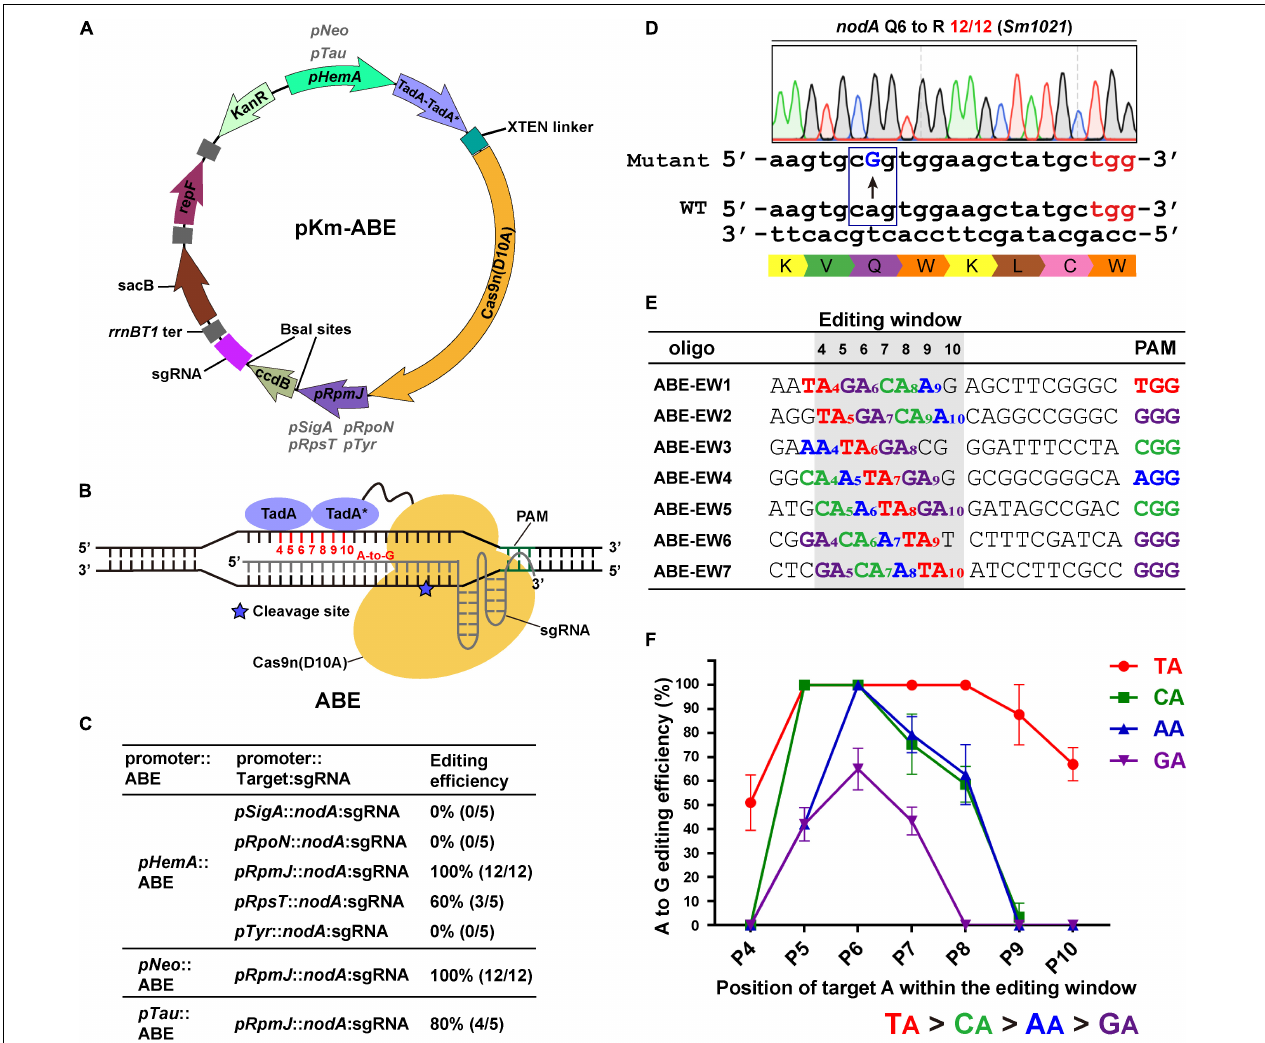
FIGURE 1 | Adenine base editor (ABE) systems catalyze efficient A-to-G conversions in Sinorhizobium meliloti . (A) Map of the pKm-ABE plasmid. KanR: the kanamycin-resistant marker for selection in E. coli and the neomycin-resistant marker for selection in S. meliloti ; repF: pBBR1 origin of replication and oriT from E. coli ; rrnBT1 ter: rrnBT1 transcriptional terminator; sacB : the counter-selectable marker for plasmid curing after editing; pHemA : the δ -aminolevulinic acid synthetase gene promoter of S. meliloti ; pNeo : the constitutive neomycin cassette promoter; pTau : the taurine-inducible promoter of S. meliloti ; TadA-TadA*-XTEN linker-Cas9n: the Cas9-adenine deaminase fusion protein; pSigA : the housekeeping sigma factor σ 70 gene promoter; pRpoN : the sigma factor σ 54 gene promoter; pRpsT and pRpmJ : the ribosomal protein-related gene promoters; pTyr : the Tyr-tRNA (GTA) gene promoter; ccdB : a Bsa I-flanking ccdB cassette for spacer sequence insertions. (B) Schematic diagram of Adenine Base Editors (ABEs). TadA-TadA*: artificially evolved DNA adenine deaminase derived from E. coli tRNA adenosine deaminase (TadA). TadA*: the mutated TadA. The SpCas9 nickase (Cas9n D10A) is fused to the C-terminus of the TadA-TadA* and XTEN linker cassettes. The estimated activity window of ABE systems ranges from position 4 to 10 of the protospacer. The protospacer adjacent motif (PAM) ranges from position 21 to 23. The asterisk indicates the cleavage site of Cas9n nickase. (C) Editing efficiency comparison of ABEs and sgRNAs expressed from various promoters. (D) Representative A-to-G base editing with an ABE system harboring pHemA :ABE and pRpmJ : nodA expression cassettes. The codon encoding Q6 of the nodA gene in the S. meliloti was successfully mutated to a codon encoding R with an efficiency of 12/12. The mutated sites are colored blue. The PAM sites are colored red. (E) Seven oligonucleotides designed to investigate position effects and optimal NA combinations on editing efficiency of ABE systems. Each NA combination varied from position 4 to 10 within the protospacer. The editing window is shaded in light gray. (F) A-to-G editing efficiencies of various NA combinations and